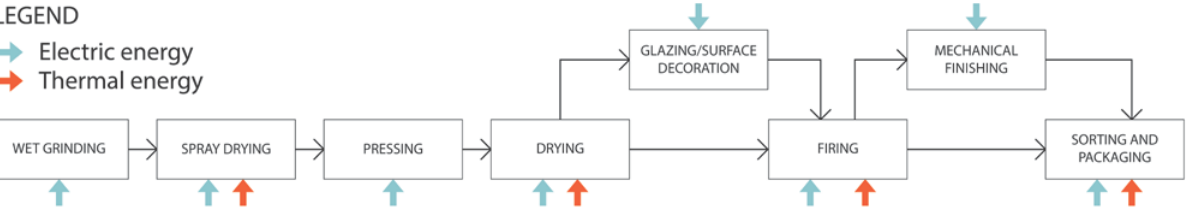
Figure 1. Distribution of energy vectors in the production process of ceramic tiles.